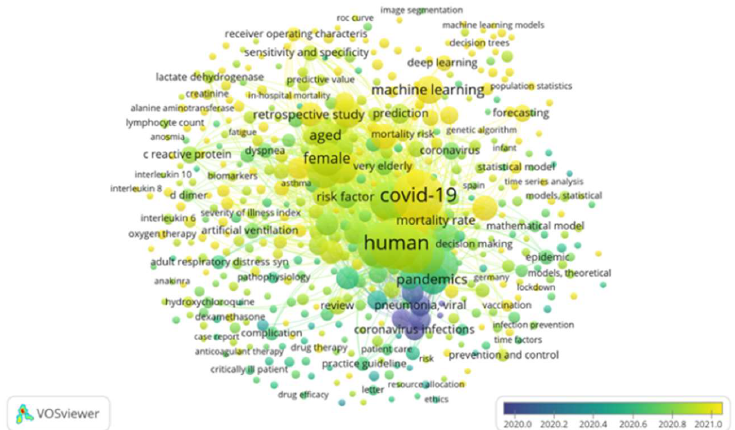
Figure 9. Co-word network visualization in the research topic “ML applied to COVID-19”. Note: